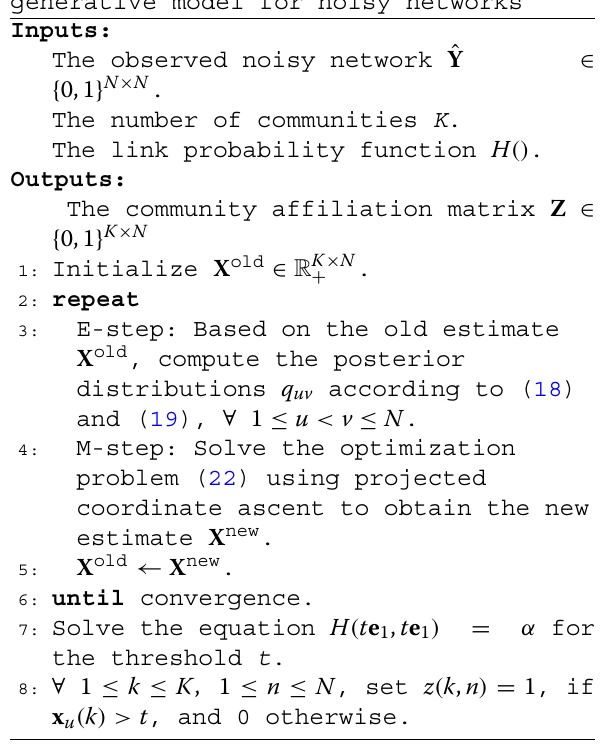
Algorithm A general community detection algorithm for the proposed game-theoretic generative model for noisy